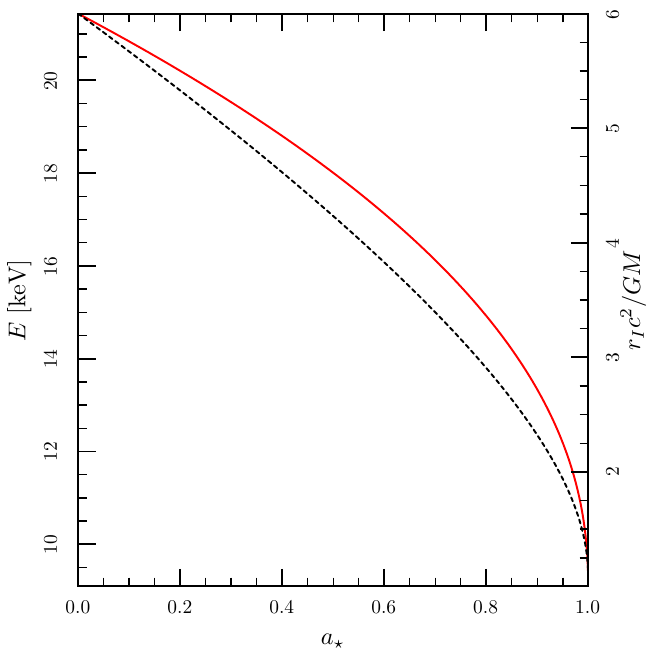
Figure 1. The plot shows, on the left y − axis, the energy at which r p = r I ( solid red line ). On the right y − axis, the ISCO for a black hole as function of the spin parameter a (cid:63) ( dashed black line ). Figure from